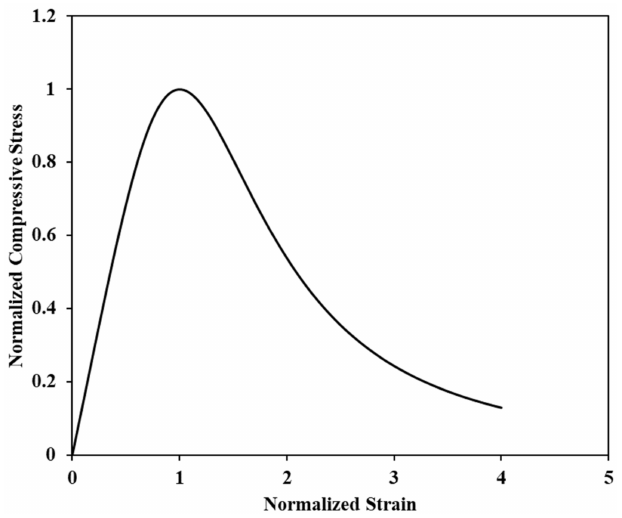
Figure 3. Normalized stress–strain curve according to Hsu et al.